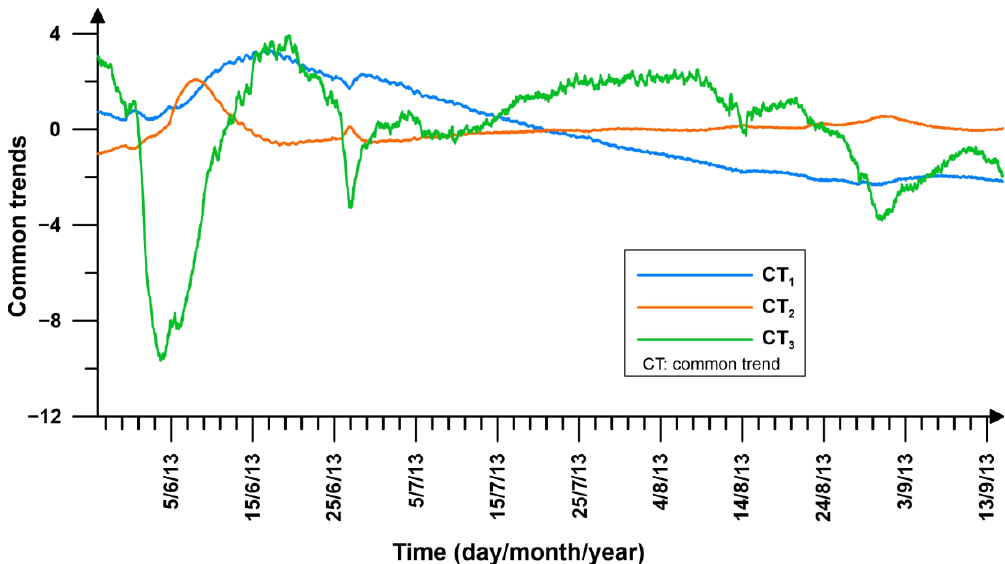
Figure 3. The common trends of groundwater levels.